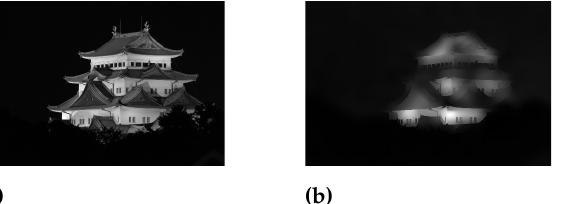
Figure 4. Restored image with multiplying R and L . ( a ) R is Figure 3b, and the output is the same as Figure 2 grayscale. ( b ) R is Figure 3c and the output is not